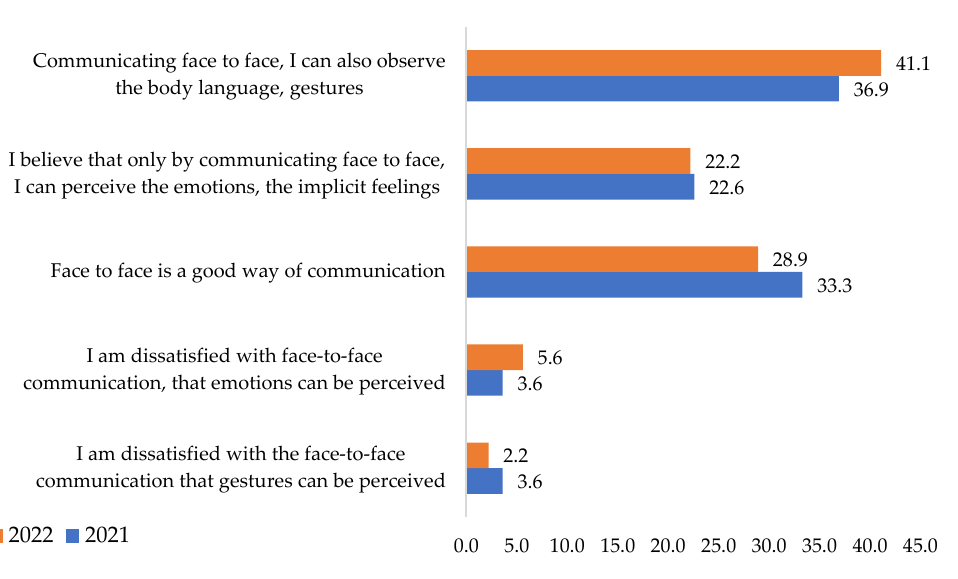
Figure 5. Respondents’ preferences regarding face-to-face communication. Source: Data from field quizzes, 2021, 2022.